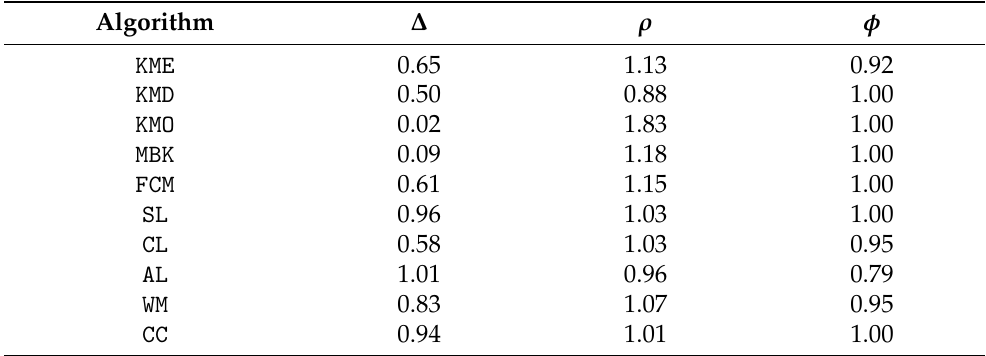
Table 7. Footprint analysis of the algorithms after the inclusion of real datasets, where ∆ is the area, ρ is the density and φ is the purity.